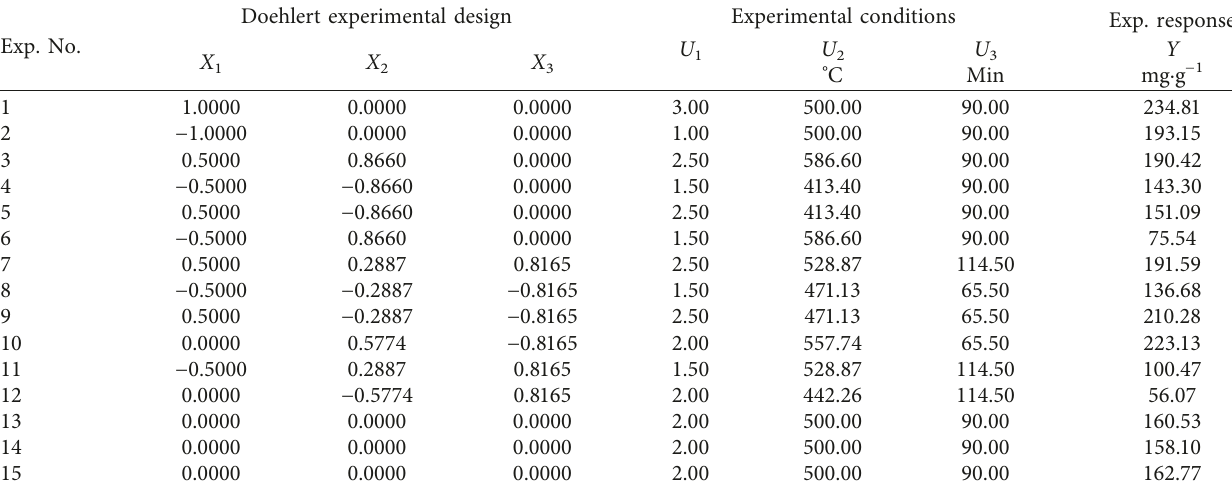
Table 2: Doehlert experimental design, experimental conditions, and experimental results. Exp. No.